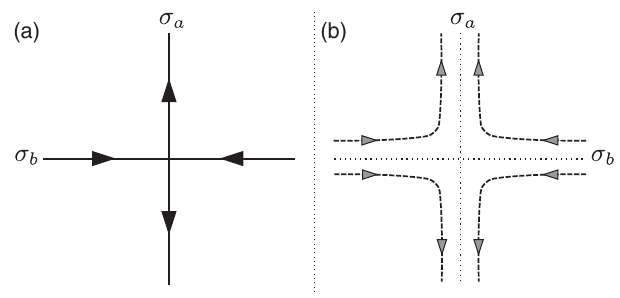
FIG. 11. (a) Adjoining 2D sheets (solid lines) to a reduced system with C 2 v symmetry defined on the mirror planes (dashed lines). The arrows indicate one choice of edge chiralities when the adjoined sheets are E 8 states. (b) – (d) Adjoining 1D systems, shown as filled